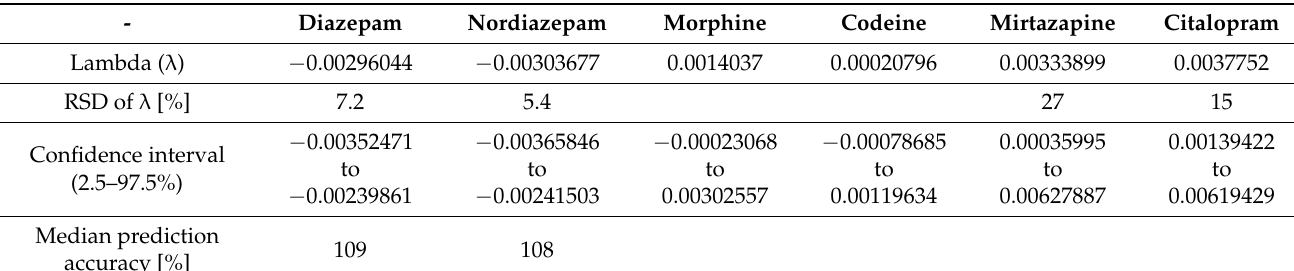
Table 2. Summary data on the parameters for the mixed effect models; RSD refers to the relative standard deviation of lambda upon repeating model creation with a randomly selected training set for 50